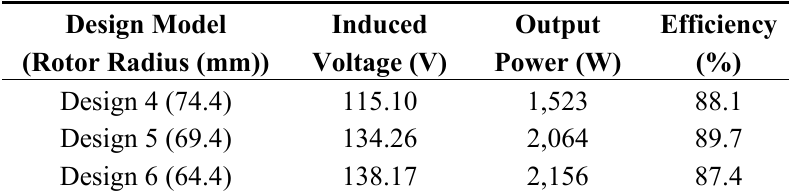
Table 4. Output power and efficiency.